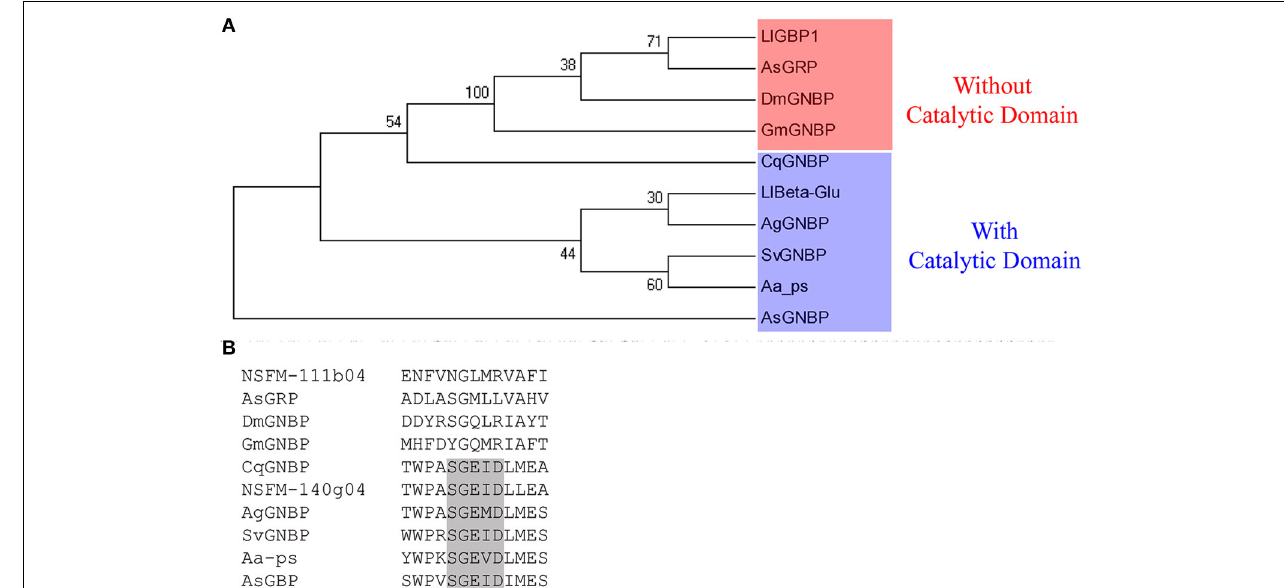
FIGURE 1 | Cladogram of selected GH16 proteins from the order Diptera. (A) Phylogenetic tree was done using sequences from Armigeres subalbatus (accession number AAT99011), Glossina morsitans morsitans (ABC25063), Drosophila melanogaster (AAF33851), Anopheles gambiae (ACN38130), Culex quinquefasciatus (AEQ27734), and Simulium vittatum (ACH56895). Actinophrys sol (Porifera, BAG32349) was used as outgroup. The sequences